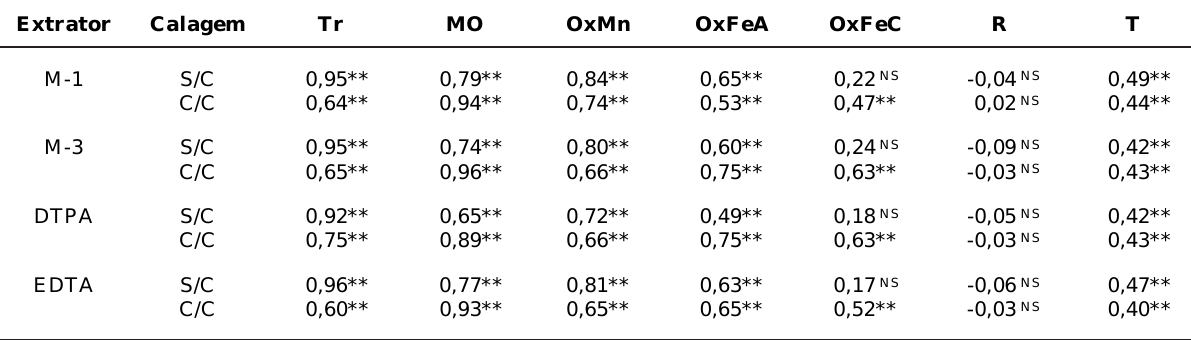
Quadro 4. Coeficientes de correlação linear simples entre os teores de zinco por Mehlich-1, Mehlich-3, DTPA e EDTA e as frações: trocável, matéria orgânica, óxido de manganês, óxido de ferro amorfo, óxido de ferro cristalino, residual e teor total de amostras de seis solos, com (C/C) e sem calagem